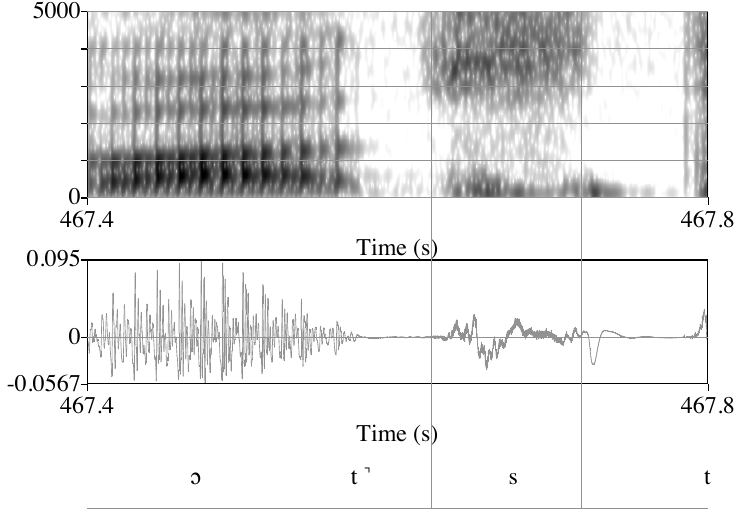
Figure 1 . Measurement of English stimuli without vowel prothesis (He b[ɔt st]amps).